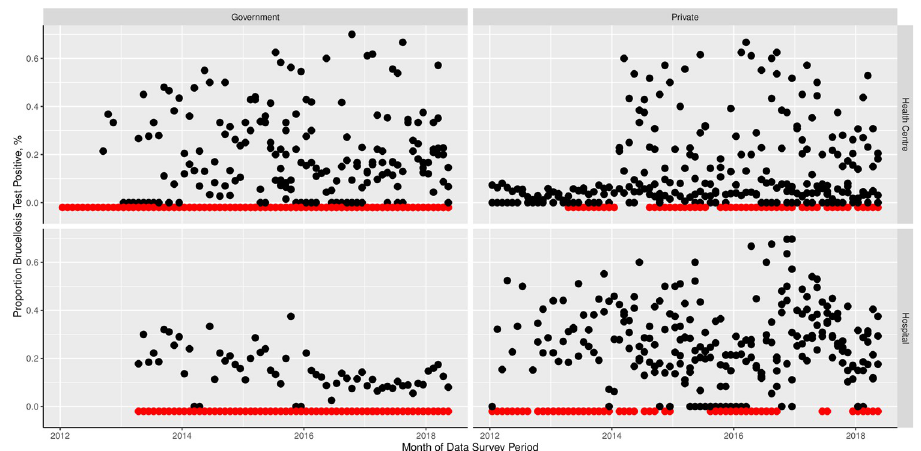
Fig 4. Proportion of individuals tested per month receiving a brucellosis positive laboratory test result over time. The plots show data from all facilities and months included in the model analyses. Red points just below y = 0 indicate months and facilities in which no brucellosis testing was performed. Panels show the data subset by facility ownership (government or private) and facility classification (health center or hospital).